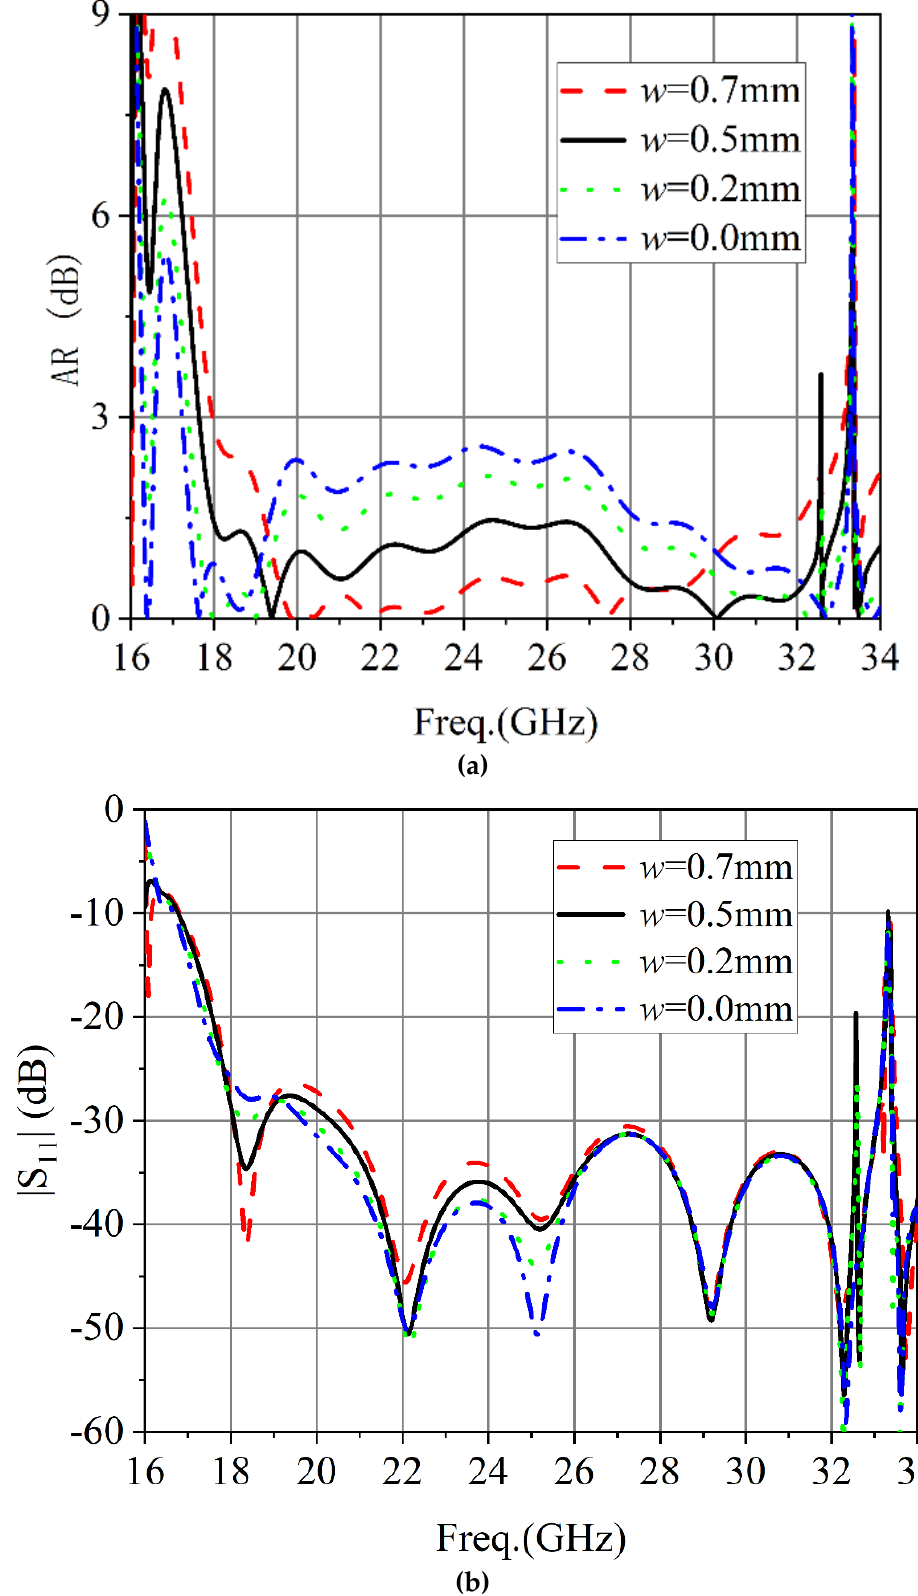
Figure 8. Simulated results of different hole position of the metal via hole: ( a ) AR. ( b ) |S 11 |.